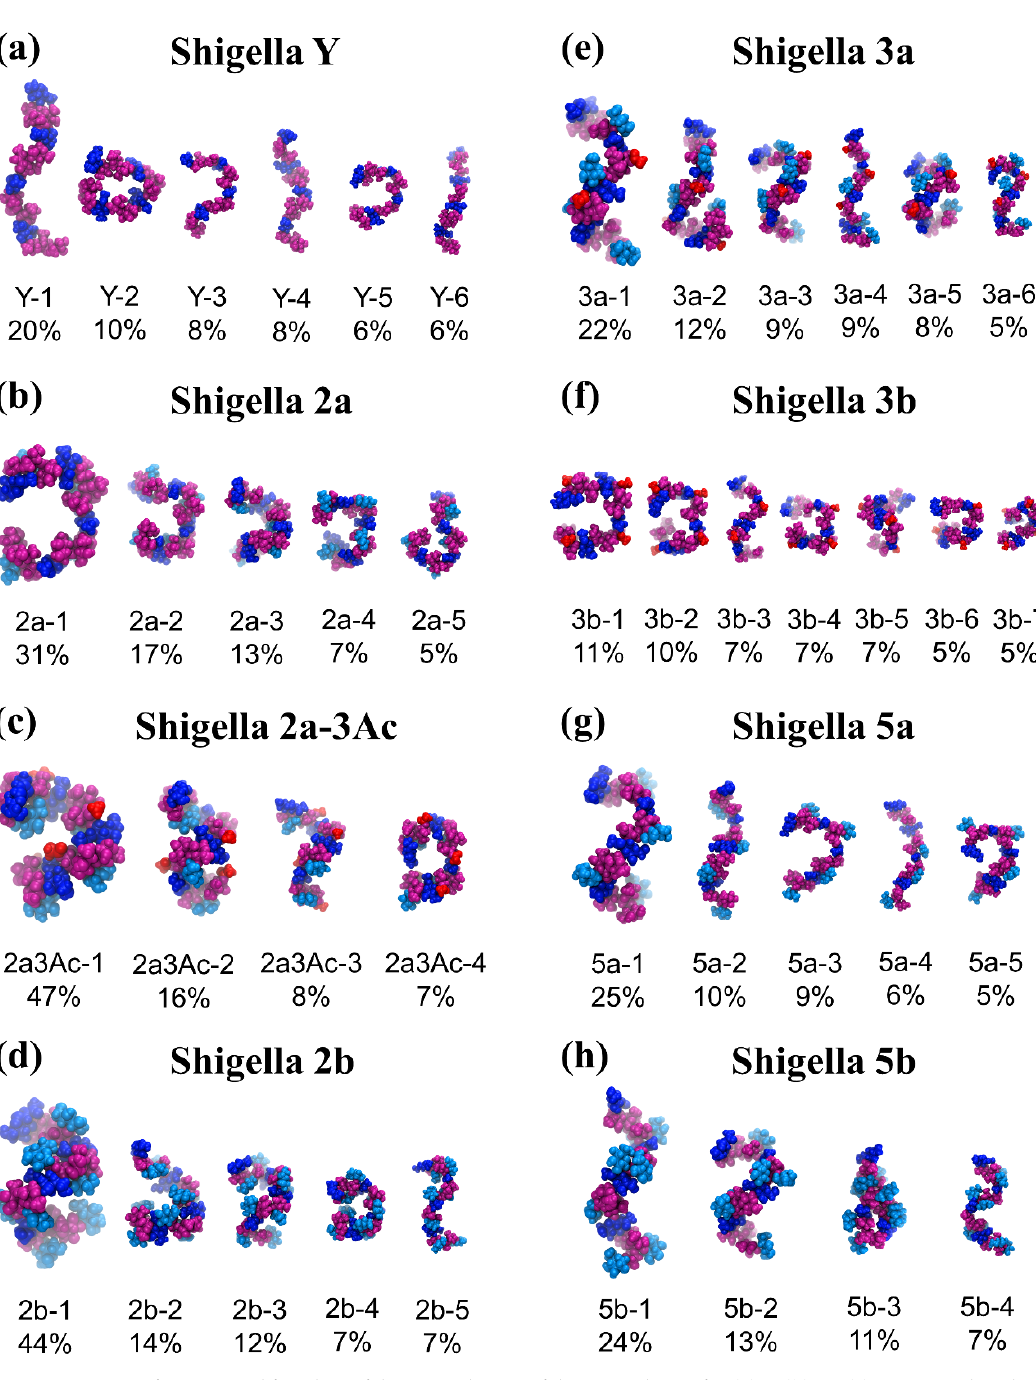
Figure 3. Conformational families of the central 4 RU of the 6 RU chains for ( a ) Y, ( b ) 2a, ( c ) O-3-acetylated 2a, ( d ) 2b, ( e ) 3a, ( f ) 3b, ( g ) 5a, and ( h ) 5b. Relative occupancies in the simulations (excluding the initial 200 ns) are indicated as percentages. Clusters of less than 5% are not shown. The sugars are colored: pink for Rha, dark-blue for GlcNAc, cyan for Glc side chains, and red for O-acetyl groups. Serogroup 5b adds O-factor 7,8 (glucosylation on O-3 of rhamnose A) which, according to